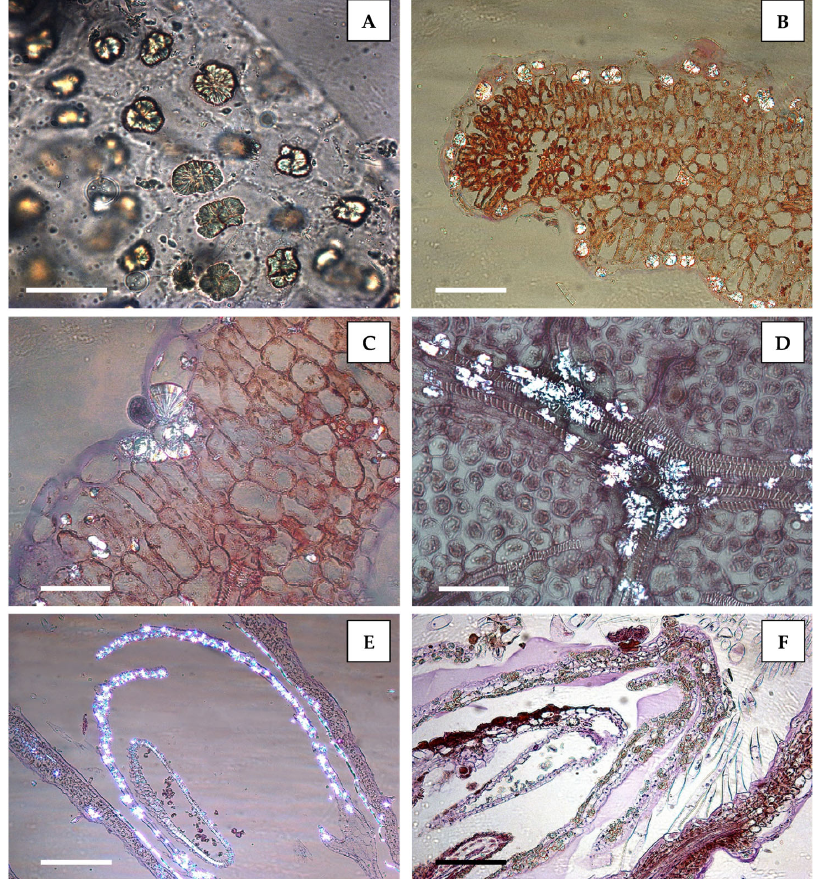
Figure 1. Spherocrystalline masses of diosmin were abundant in the leaf epidermal cells ( A , B ), sometimes crowded at the base of trichomes ( C ), as well as along the leaf veins ( D ). These crystals were also visible inside the thin petals of the flowers ( E , F ). A: Leaf peelings mounted in water, where diosmin spherocrystals appear unstained. ( B – F ): Paraffin-embedded samples and semithin sections stained with hematoxylin–eosin. Cross section ( B , C ) and transdermal section ( D ) of a leaf; longitudinal section of a flower ( E , F ). Aggregates of diosmin crystals were birefringent under polarized light in both leaves and flowers ( B – E ) but remained unstained when treated with hematoxylin–eosin staining ( F ). Bars: A = 50 µ m; B = 100 µ m; C = 50 µ m; D = 50 µ m; E = 100 µ m; F = 100 µ